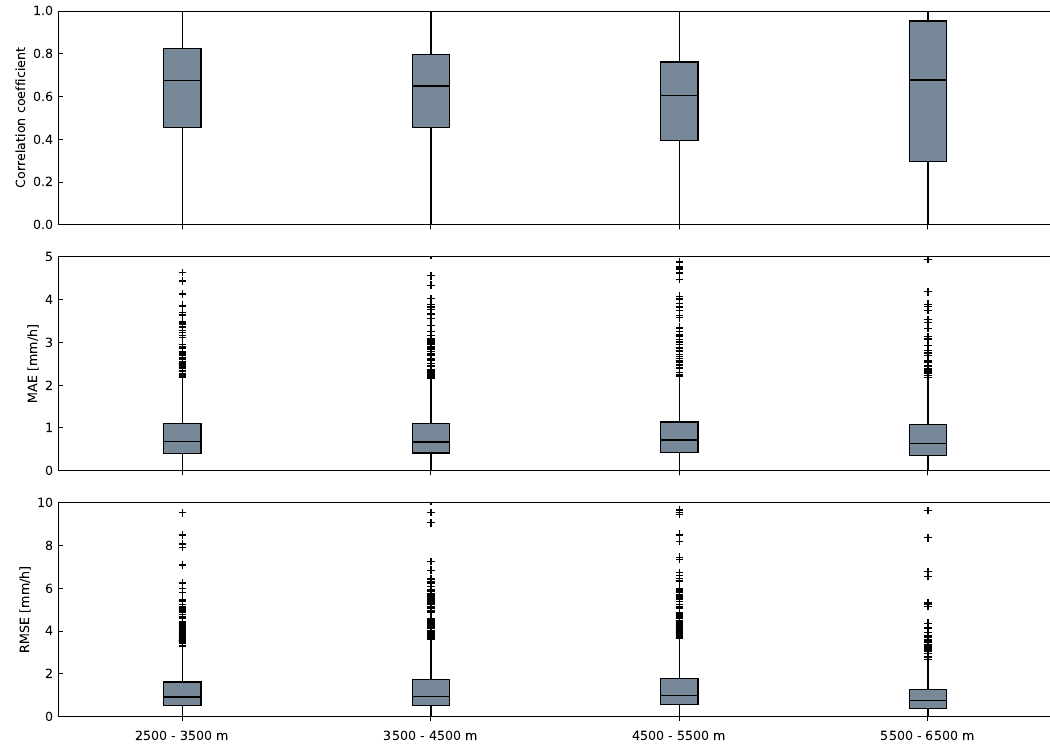
Figure 6. Validation measures correlation coefficient R, mean absolute error (MAE), and root-mean-square error (RMSE) of the predicted precipitation rates against the gauge calibrated MW precipitation rates sorted by elevation ranges in 1000 m steps. The boxes display the percentiles (25th, 50th, and 75th). The whiskers indicate extreme data up to 1.5 times of the interquartile range. Crosses mark outliers. The width of the boxes is relative to the number of validation